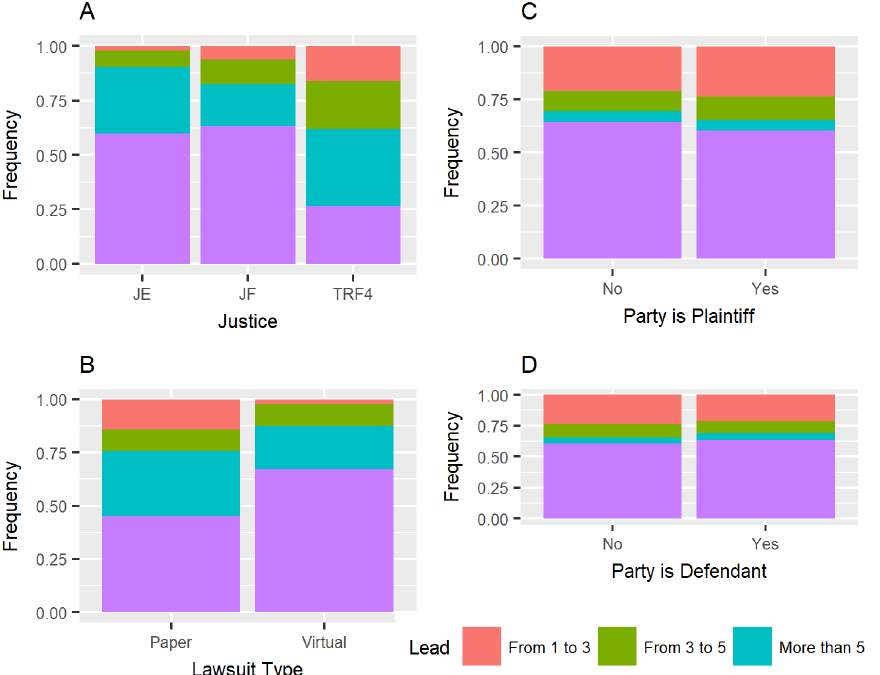
Fig 4. A—Justice type and lead time, B—lawsuit type and lead time, C—main plaintiff and lead time, D—main defendant and lead time.